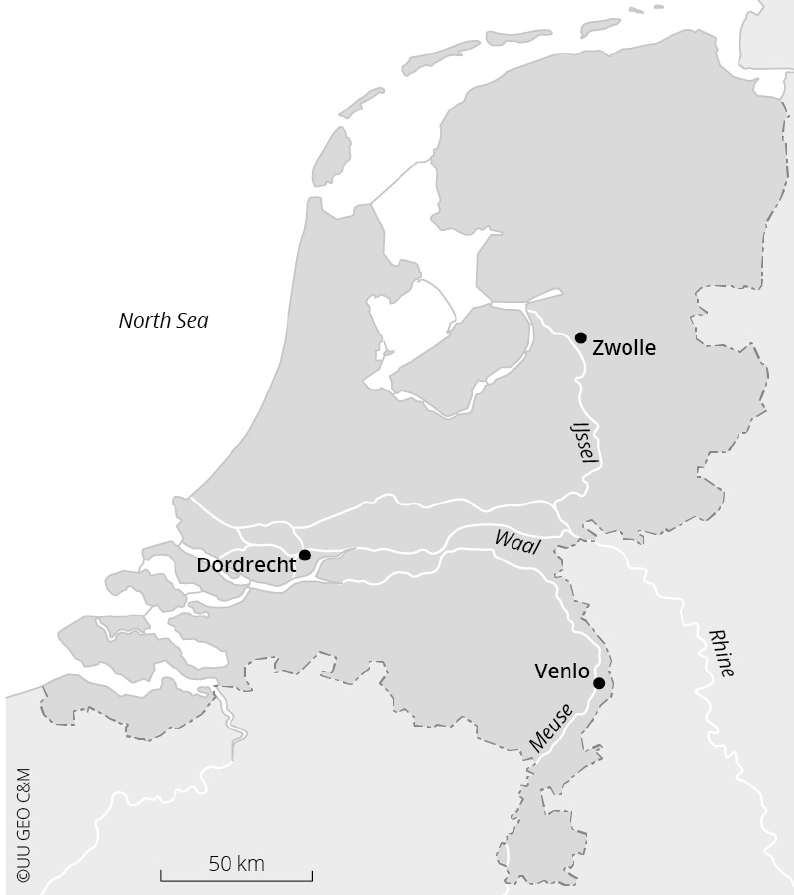
Figure 3. Case study locations within the Netherlands. Source: Snel et al.